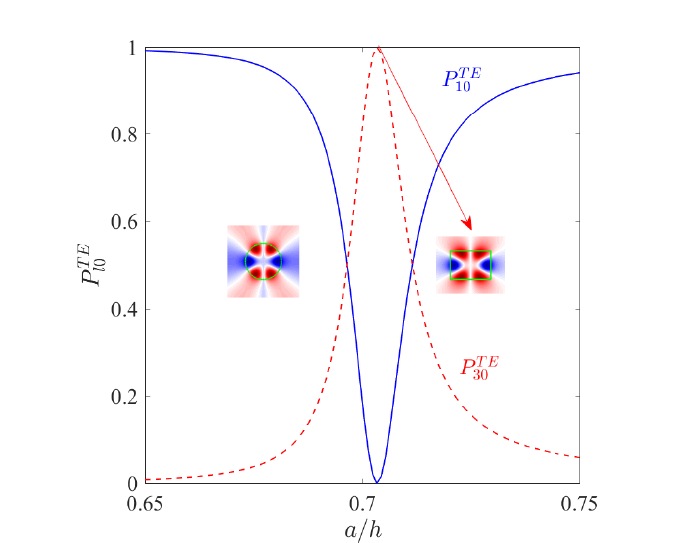
Figure 10. Evolution of the TE multipole radiated powers from one disk vs the aspect ratio in isolated disk for the case shown in Figure